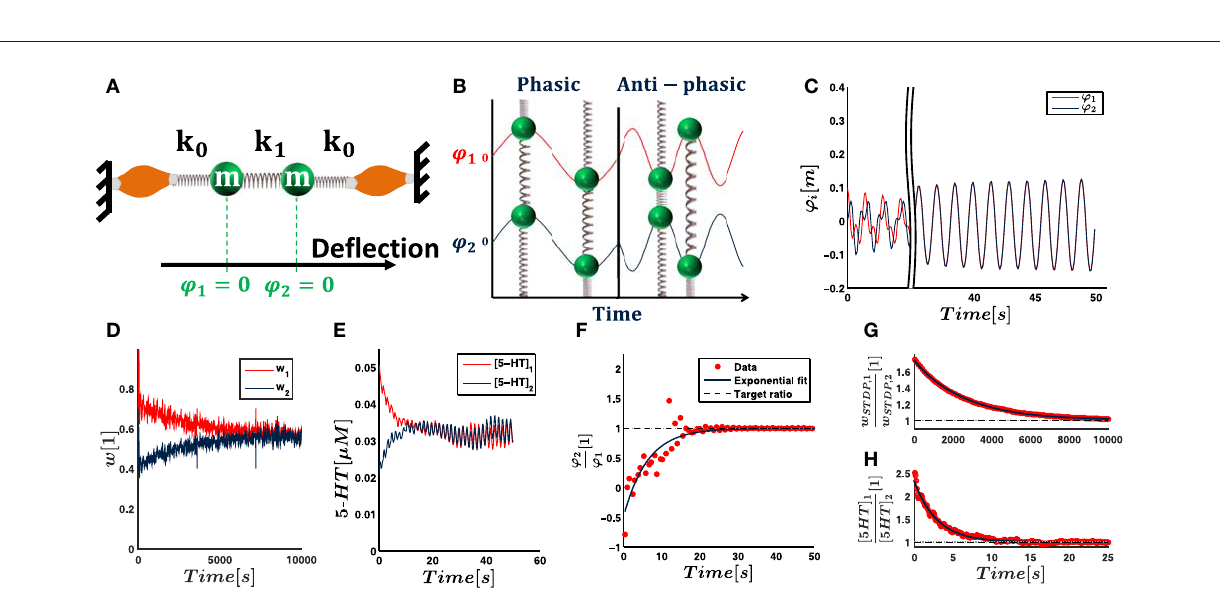
its eigenmodes, showing no obvious relationship in phase or amplitude between the two masses. The trajectories of the two masses converge to synchronous resonant movements over